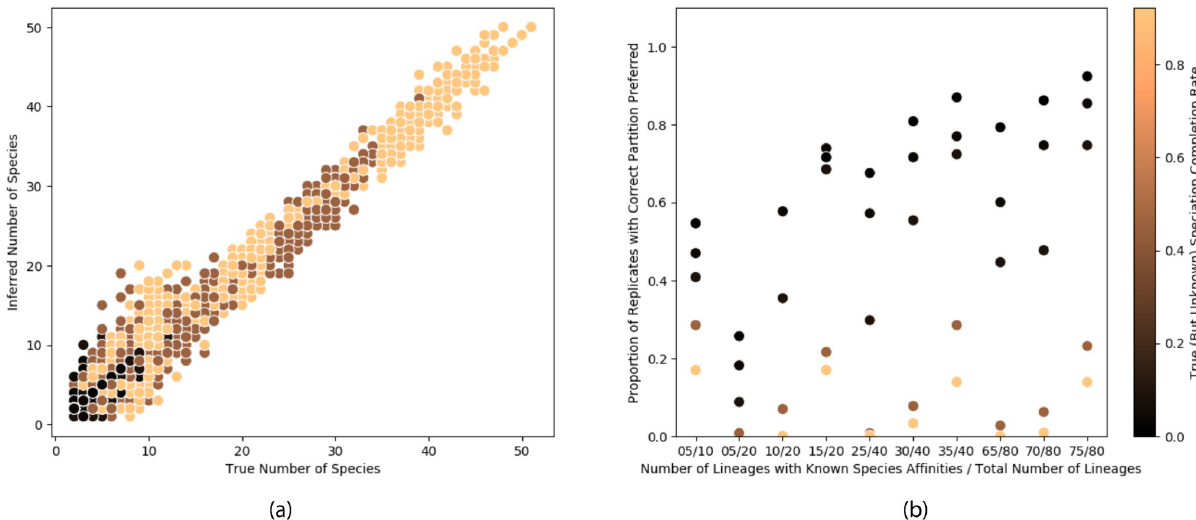
Fig 2. Overview of speciation-based delimitation using DELINEATE . Starting with genomic data (a), a lineage tree (b) is inferred under the multispecies coalescent (MSC) model using any of a number of programs, such as BP&P [28] or � BEAST [30]. The inferred lineages, which are consistent with a Wright-Fisher population under the MSC model (i.e., cannot be divided any further), are (c) organized into sets of one or more species in DELINEATE , with each possible organization (referred to as a “partition”) representing a different hypothesis about species boundaries. Partitions can range from a single species (i.e. all lineages assigned to the same species) to as many species as their are lineages (i.e., there are no population lineages, only different species). The probability of each of the different partitions is calculated and reported by DELINEATE , The partition with the highest probability is the maximum likelihood estimate, but investigators have at their disposable all the partitions in the 95% confidence interval as well if they wish to summarize support for particular results as well.